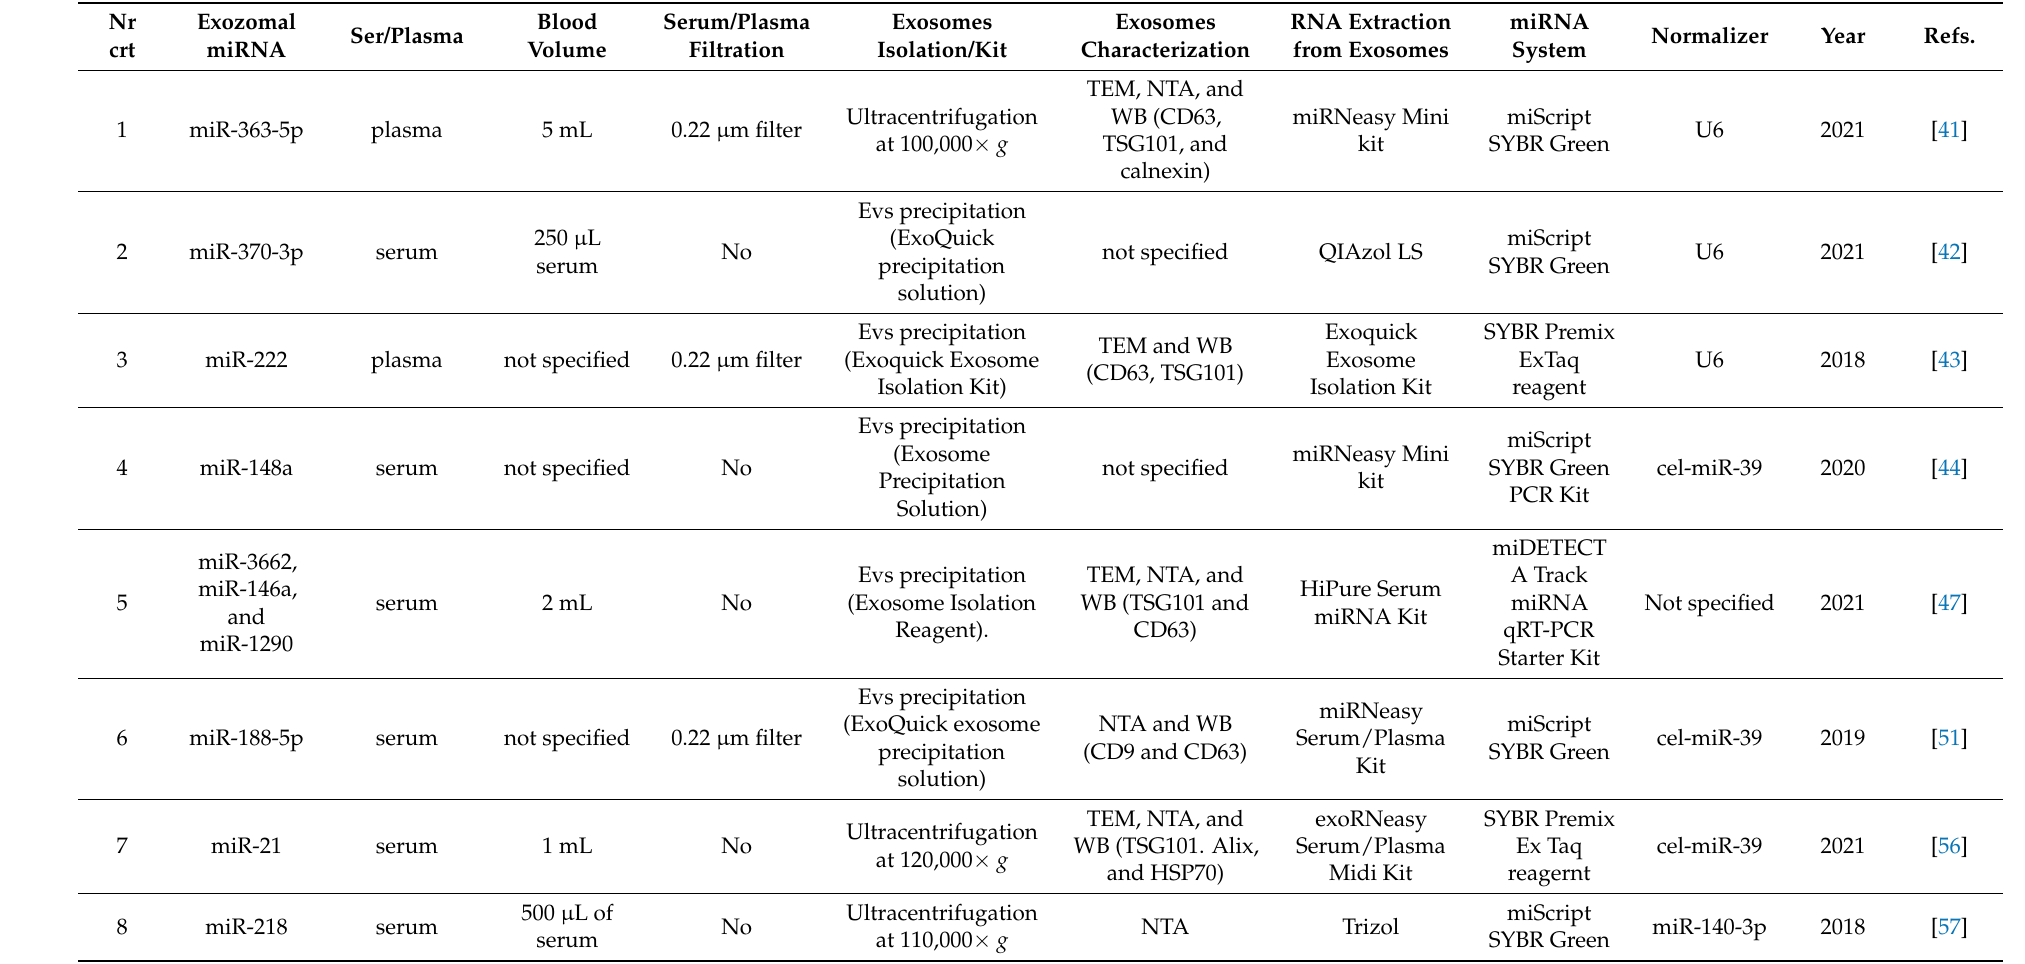
Table 2. Validated exosomal miRNA biomarkers useful for translational research with clinical